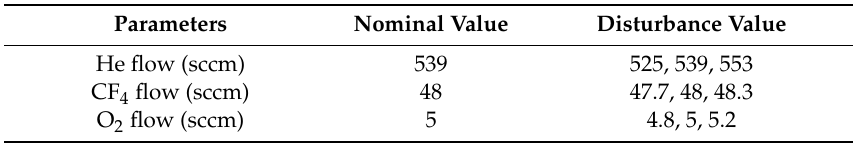
Table 2. Process parameters for small disturbance robustness.